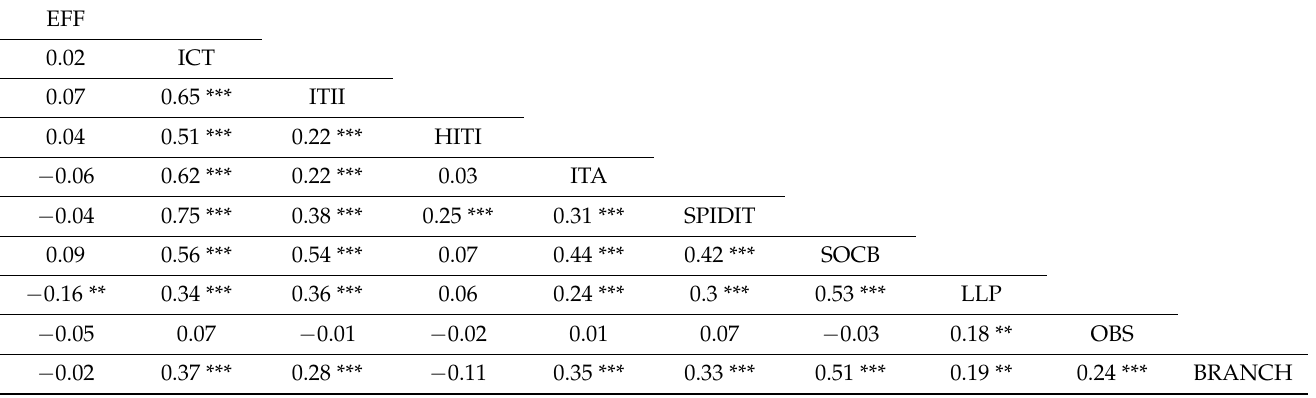
Table 2. Correlation matrix of variables .